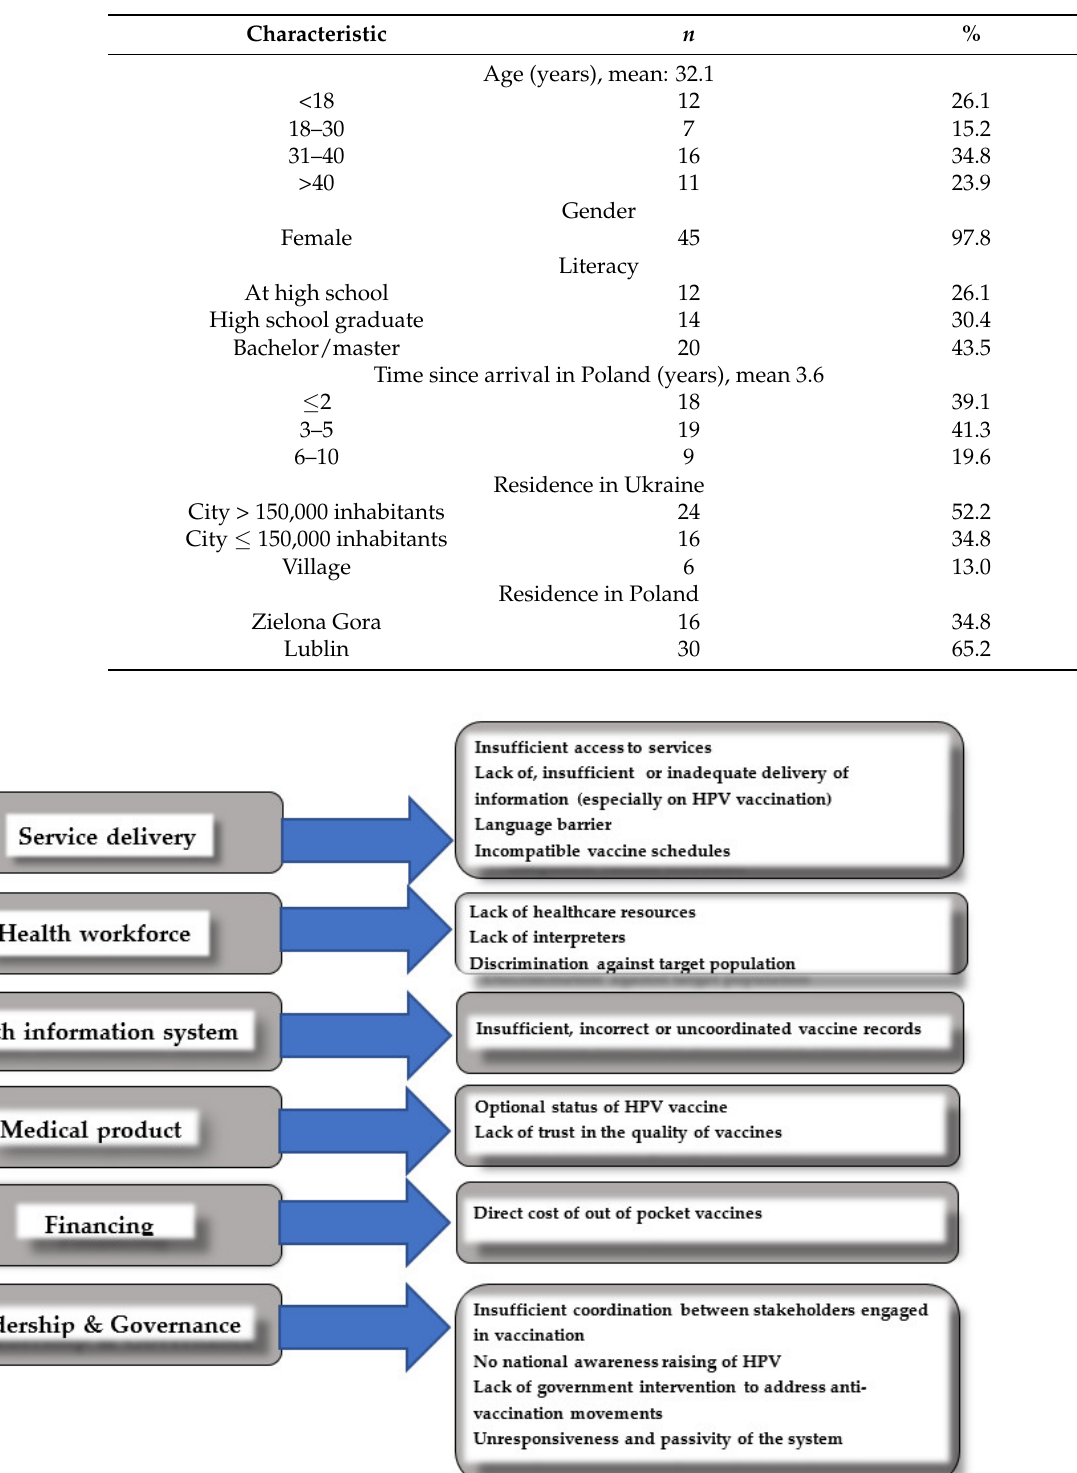
Table 1. Demographics of study participants: Ukrainian migrants ( n = 46).